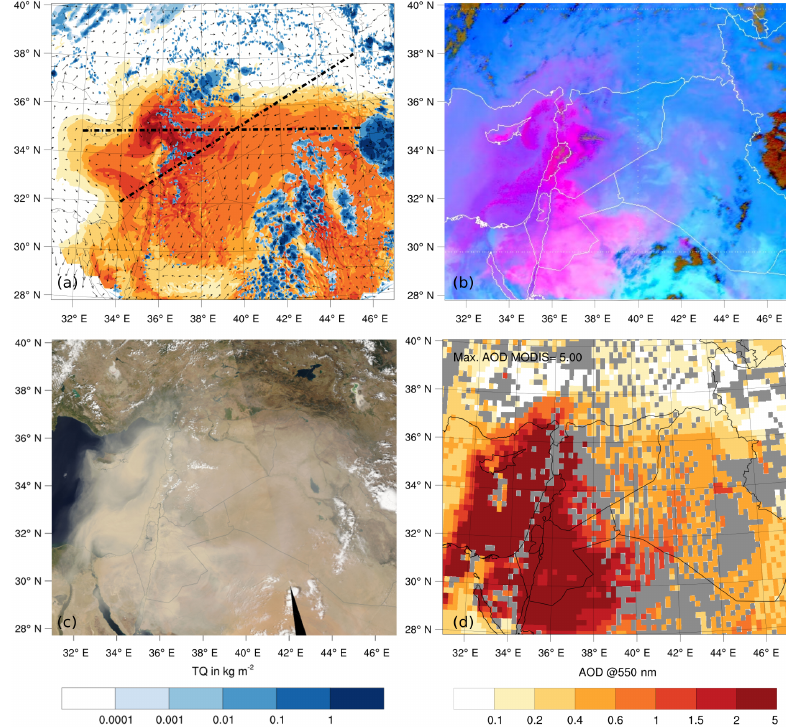
Figure A6. ICON-ART model results and satellite observations at 11:00UTC, 8 September. The chain dotted black lines mark the locations of the cross sections displayed in Fig. A4 along the 35 ◦ N circle of latitude for the left-hand two-figure column and from 32 ◦ N, 34 ◦ E to 38 ◦ N, 46 ◦ E for the right-hand two-figure column. Displayed are (a) ICON-ART DOD, column-integrated hydrometeor content and wind velocity; (b) the SEVIRI RGB dust product (Kerkmann et al., 2015); the (c) Aqua MODIS VIS satellite image, overpass for the left part of the picture at 11:18UTC (NASA Worldview, 2016); and (d) the Aqua MODIS AOD retrieval using the DB2 algorithm (Levy and Hsu, 2015), overpass for the left part of the picture at 11:18UTC.